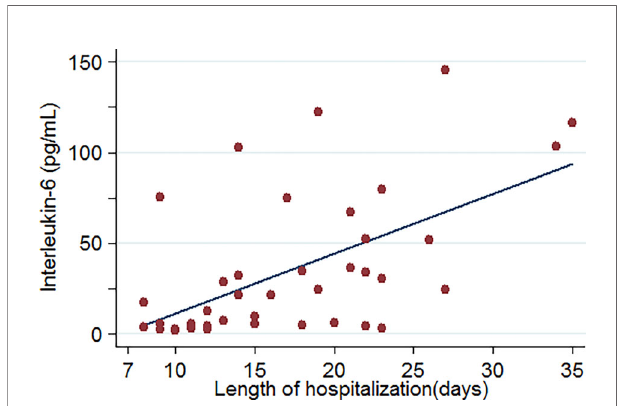
FIGURE 4 | Relationship between IL-6 levels and length of hospitalization of COVID-19-related pneumonia patients (data were available for 46 patients).